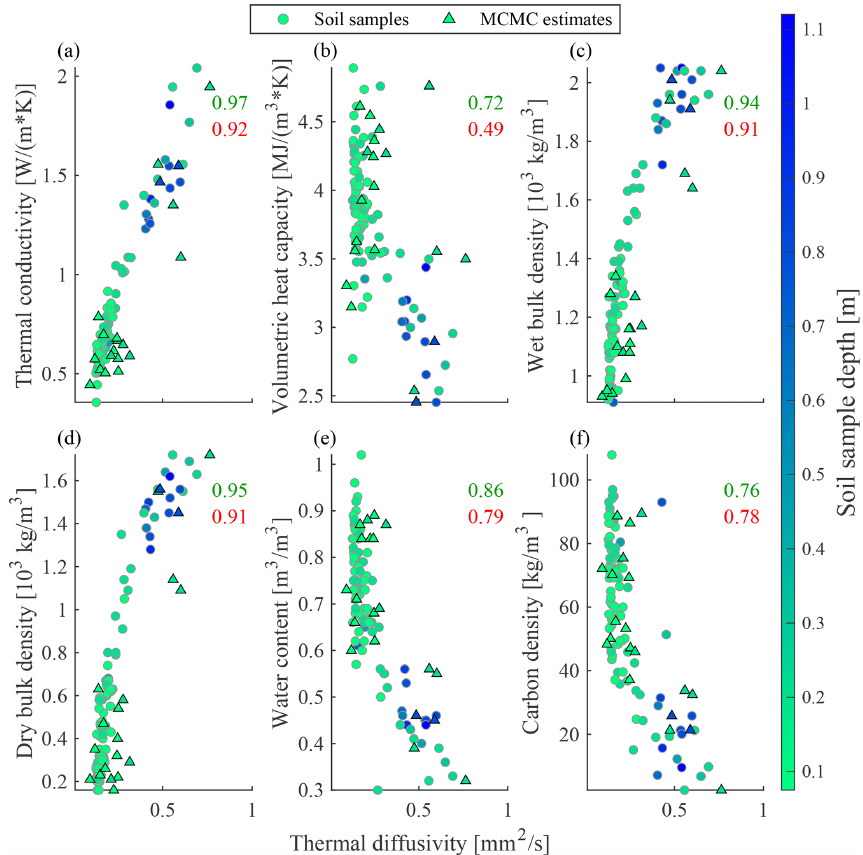
Figure 7. Relationship between soil thermal diffusivity and (a) thermal conductivity, (b) volumetric heat capacity, (c) wet and (d) dry bulk density, (e) water content, and (f) carbon density for 92 soil samples collected across the Teller site (dots) and additional comparison with collocated MCMC-inferred (triangles) thermal diffusivity. The distance correlation between measured (green number) or MCMC-inferred (red number) thermal diffusivity and the other soil thermal–physical properties is also